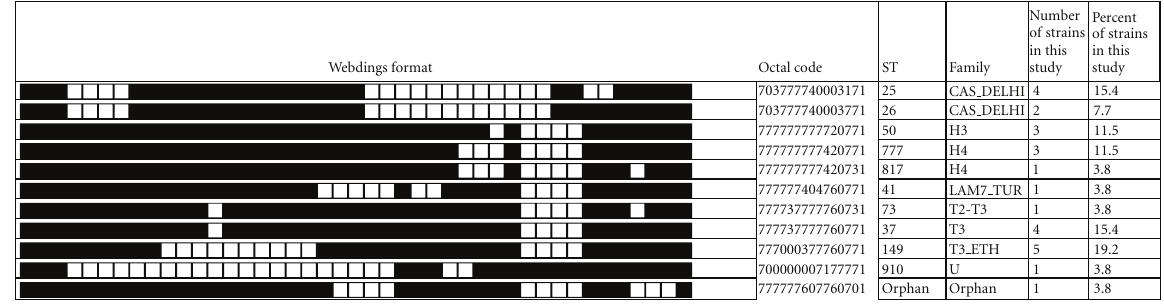
Figure 3: Spoligotype pattern of M. tuberculosis strains from HIV-positive